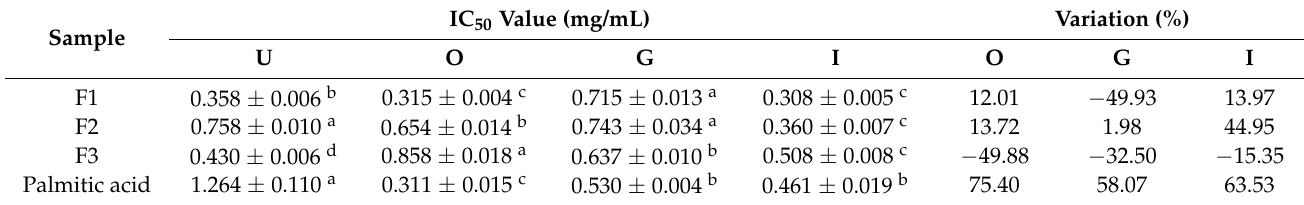
Table 1. Effect of in vitro digestion on anti- α -amylase activity of palmitic acid, F1, F2, and F3 fractionated from Sargassum